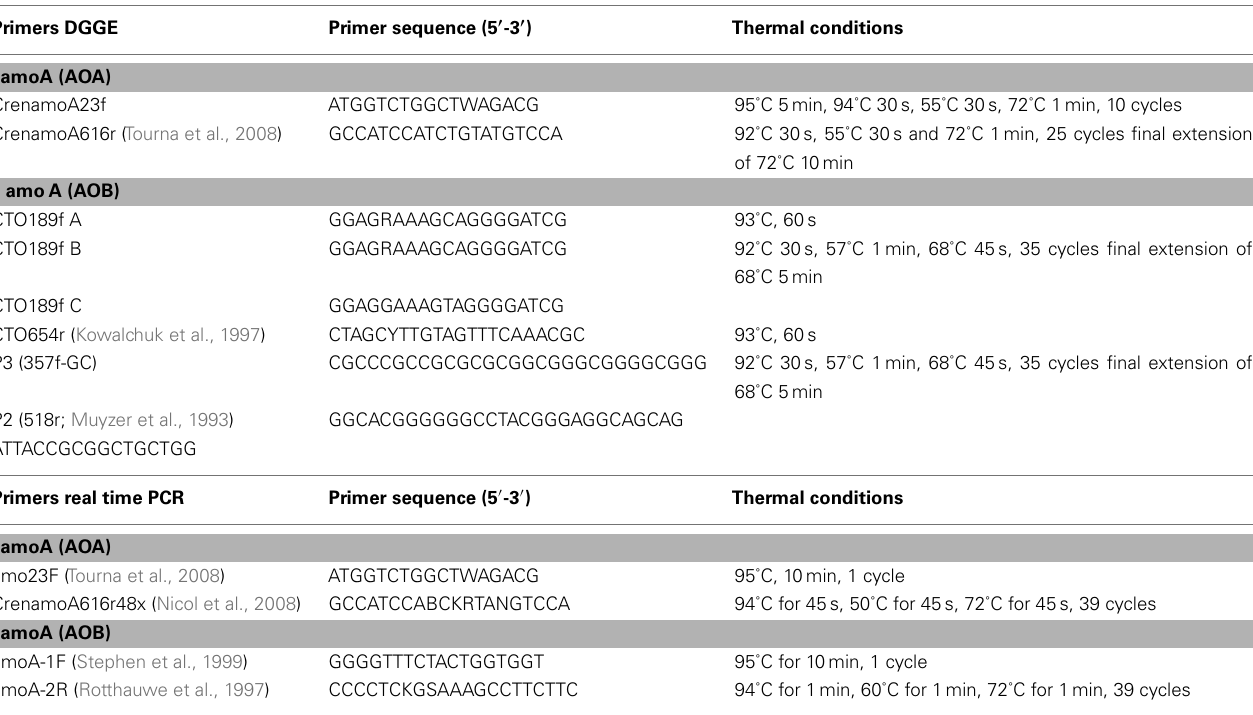
TableA2 | PCR and cycling conditions for PCR-DGGE analysis and real time quantification ofAOA andAOB genes.